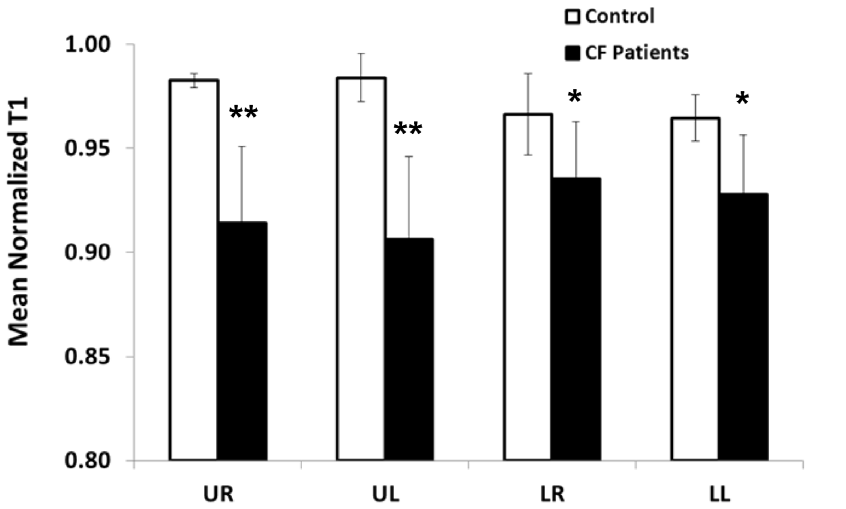
Figure 5. Comparison of mean regional nT1 values from the upper and lower lung regions for the CF patients and healthy volunteers. A significant reduction in mean (SD) nT1 (**p=0.001) was observed in the upper right (UR) [.914 (.037)] and upper left (UL) [0.906 (.040)] lung regions (black bars) for the CF patients (n=10) in comparison to the healthy control subjects (n=5) UR [.983 (.003)] and UL [0.984 (.011)] lung regions (open bars). The mean nT1 in the lower right (LR) and lower left (LL) lung regions was also significantly reduced for the CF patients in comparison to healthy volunteers (*p , 0.05). Importantly, these differences were observed despite normal spirometry in both groups.